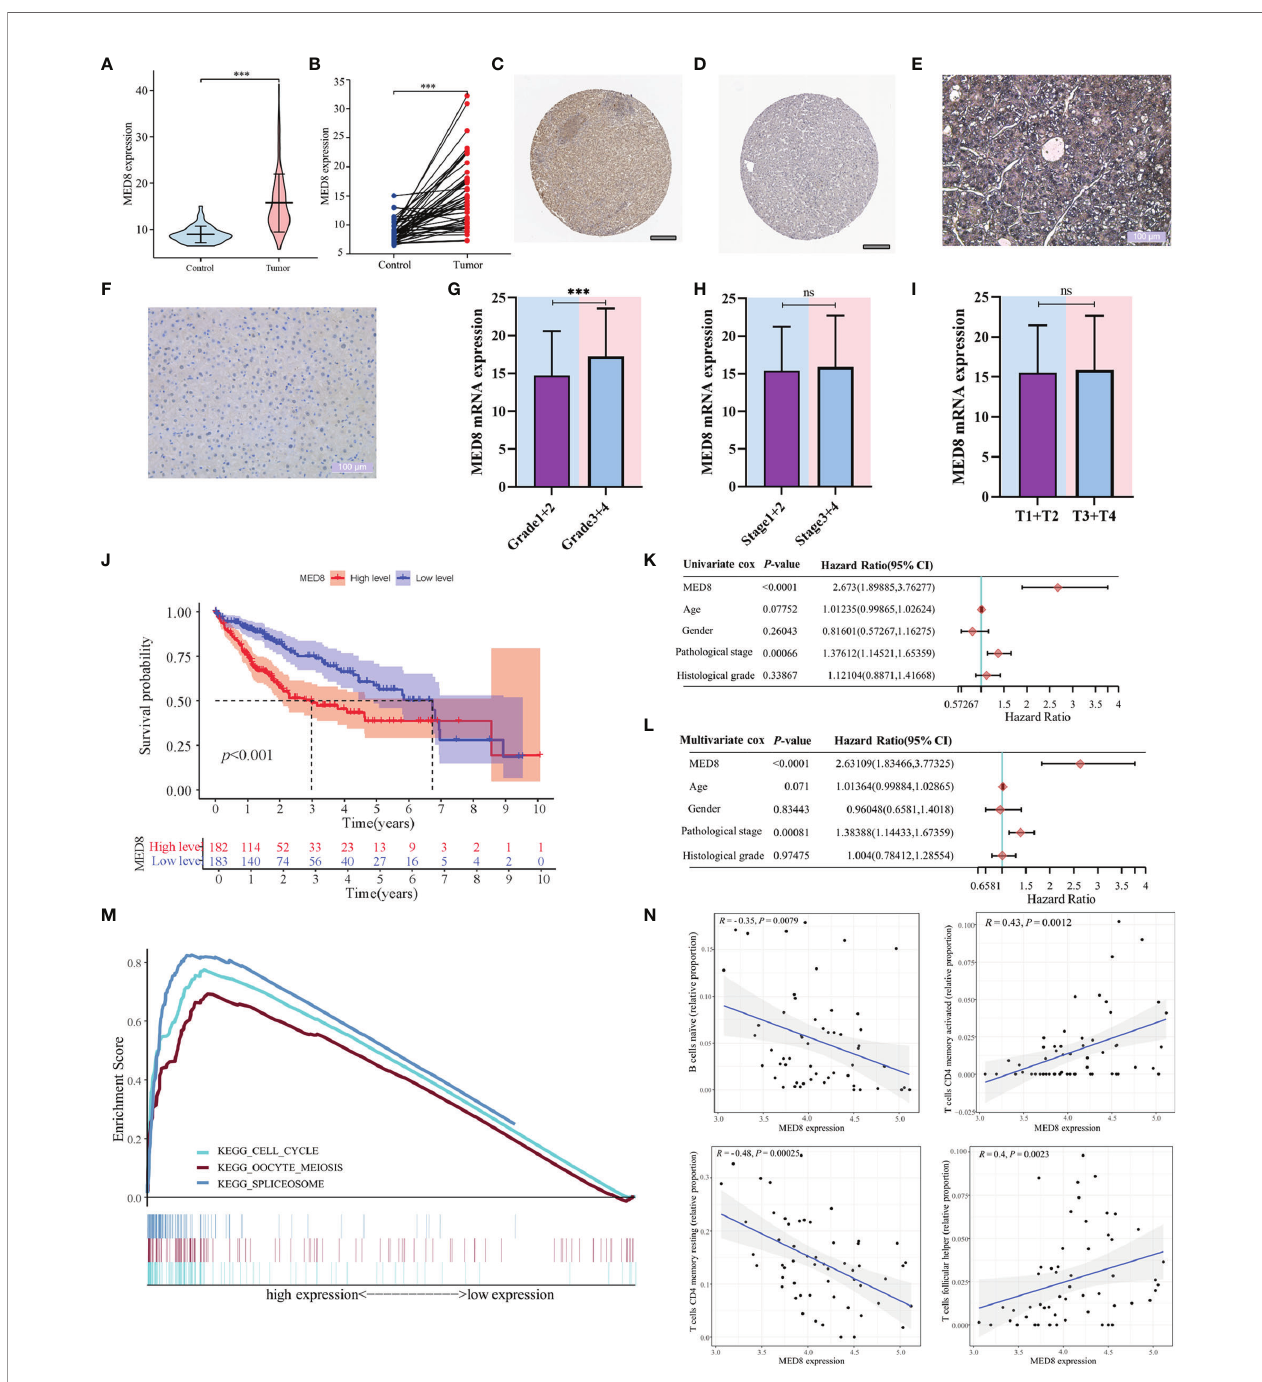
FIGURE 1 | The correlation of MED8 expression with prognoses, pathways, and immune in fi ltration in HCC. (A) The levels of MED8 mRNA expression in tumor and non-tumorous liver tissues from TCGA cohort. (B) The levels of MED8 mRNA expression in 50 matched tumor and non-tumorous liver tissues. (C, D) The levels of MED8 protein expression in tumor (C) and non-tumor liver tissues (D) from HPA database, scar bar: 200 m m. (E, F) The immunohistochemistry staining of tumor (E) and non- tumor liver tissues (F) , scar bar: 100 m m. (G – I) The levels of MED8 mRNA expression in HCC patients with different grade (G) , stage (H) and T stage (I) from TCGA-LIHC cohort. (J) The comparison of overall survival between high MED8 expression and low MED8 expression groups from TCGA-LIHC cohort. (K, L) The univariate (K) and multivariate Cox regression (L) analyses. (M) The pathways from GSEA analysis. (N) Correlation between MED8 expression and tumor-in fi ltrating immune cells. ***: P < 0.001; ns, no signi fi